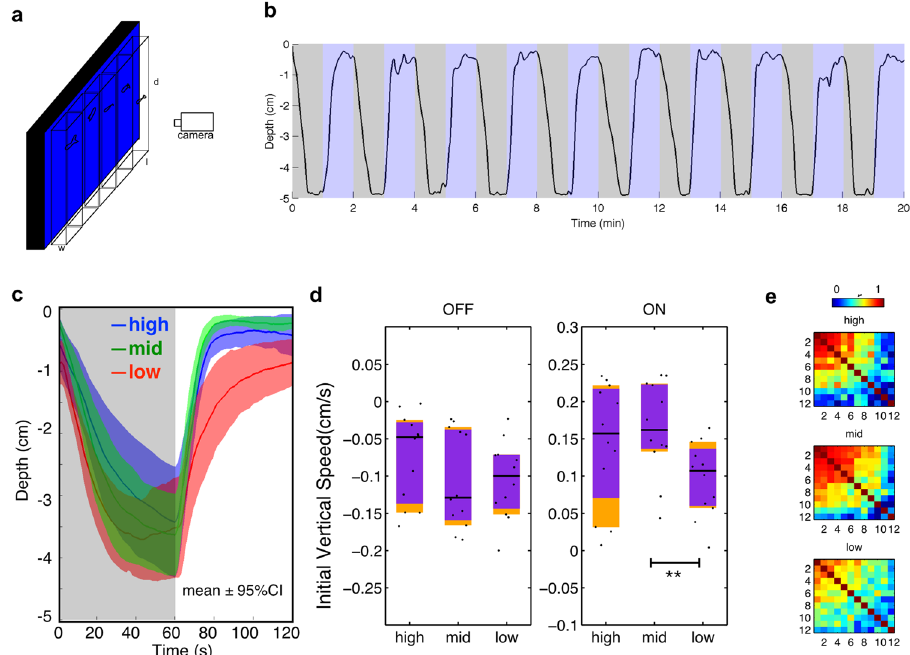
Figure 1. Blue light masks vertical migration. ( a ) Schematic of the assay. Larval zebrafish were placed individually in tanks in front of an LED backlight. ( b ) Response of 1 fish to ten cycles of blue (470 nm) light and darkness. ( c ) Depth of larvae across time under different intensities of blue light, averaged from 10 cycles. n = 12 for each group. Shadows indicate 95% confidence intervals (CIs). Mid-intensity 600 µ W/cm 2 , high-level 6000 µ W/cm 2 and low-level is ~6 µ W/cm 2 . The photon intensity of mid-level is at the level of 10 15 cm − 2 s − 1 . ( d ) Comparison of averaged initial 20 s vertical speed under different intensities of blue light. Horizontal black lines indicate median values, black dots show individual speeds, orange blocks show 95% CIs and purple blocks indicate the 25th and 75th percentiles. ( e ) Correlation coefficients of vertical position across time during 10 dark-light cycles under different intensities of light. Correlation matrices are different (mid vs high: χ 2 = 6519, df = 66, p < 0.0001; mid vs low: χ 2 = 3963, df = 66, p < 0.0001. Jennrich’s χ 2 test 45 ). For n = 3 groups, Bonferroni correction α = p /n = 0.05/3 =